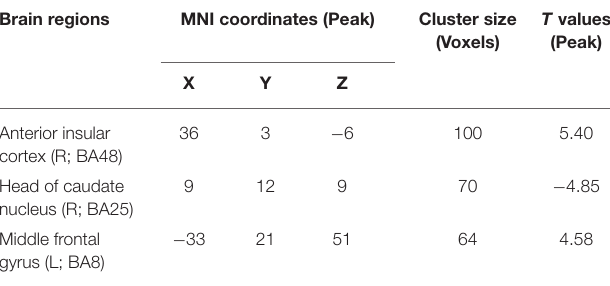
TABLE 3 | Between-group differences (PI-HC) for functional connectivity strength. Brain